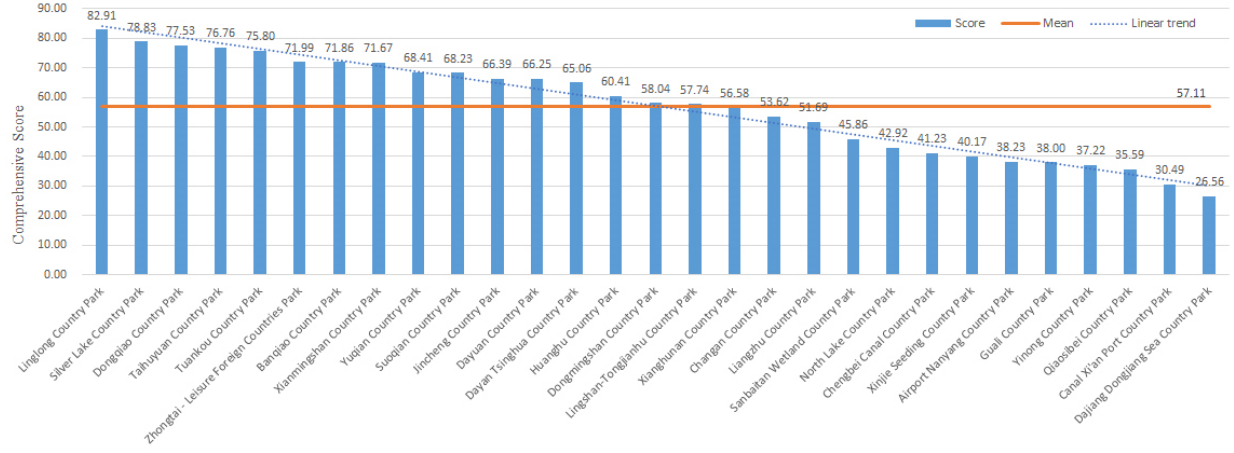
Figure 12: Figure 12: